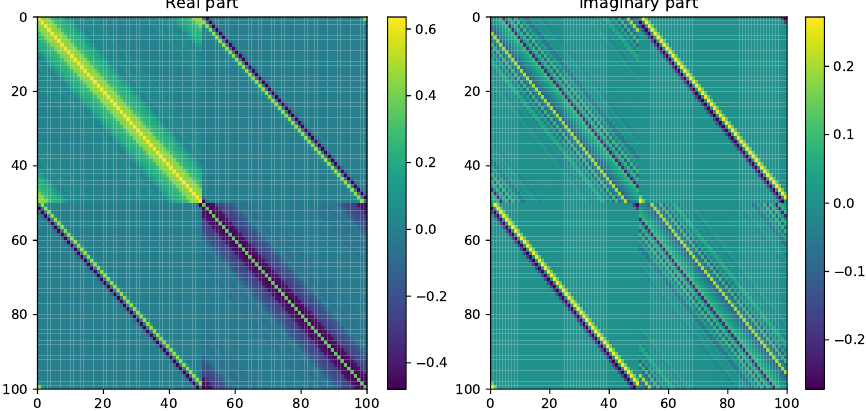
Figure 6: This is a representation of the real and imaginary part (left and right plots) of the elements of the correlation matrix Γ of a translational invariant state with exponentially decaying correlations. The element ( i , j ) corresponds to Γ ponential decay of the correlation is evident from the fading of the colours moving to matrix elements farther from the